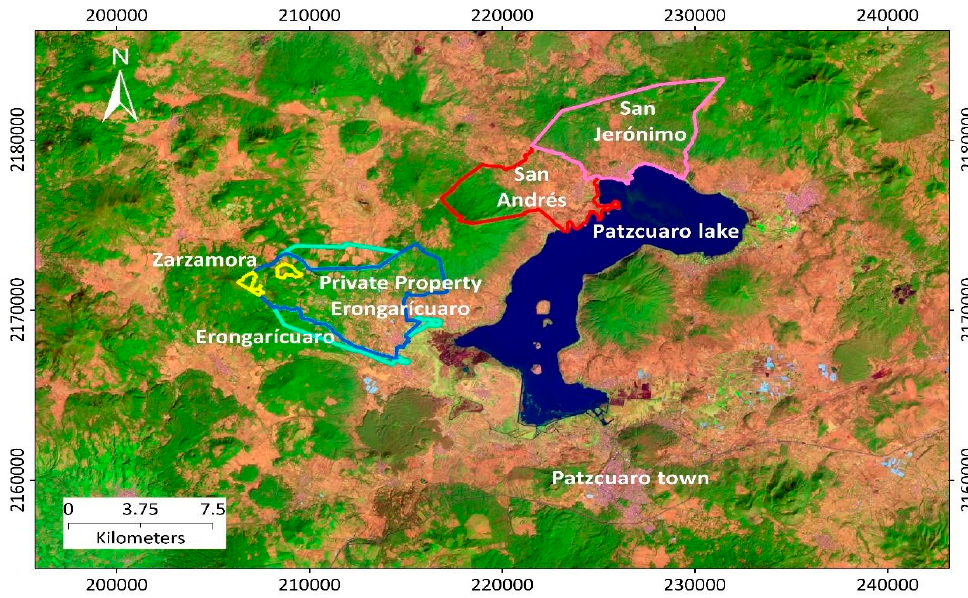
Figure 3. Five study sites in PLW, located in Michoacán state, central Mexico.